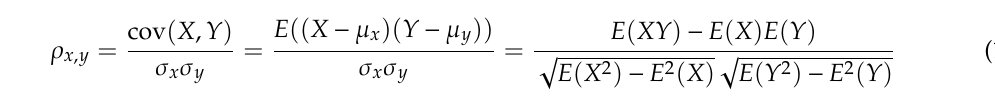
Figure 7a,b present the semi-closed-loop tracking errors of two of the same circular motions in the X and Y directions, respectively. The Pearson correlation coe ffi cients have been calculated to be